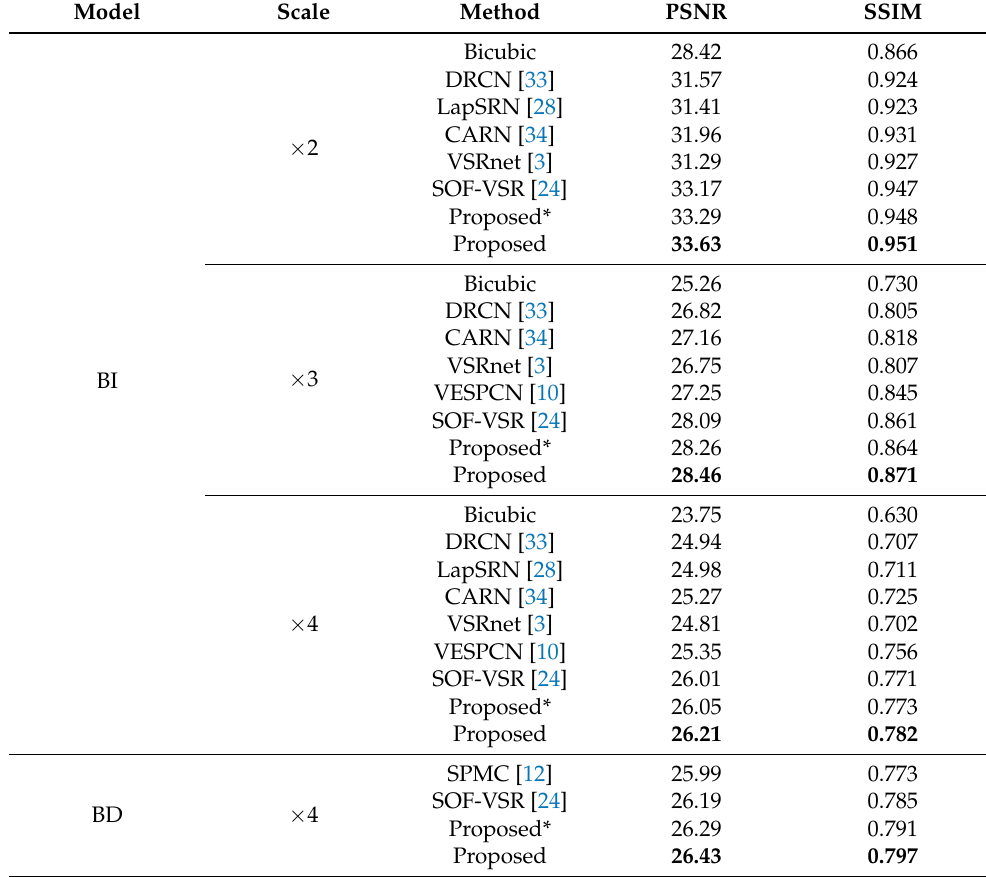
Table 4. The reconstruction results of the Vid4 dataset at different reconstruction scales. The method marked with * only used the non-local module, and the best results are indicated in